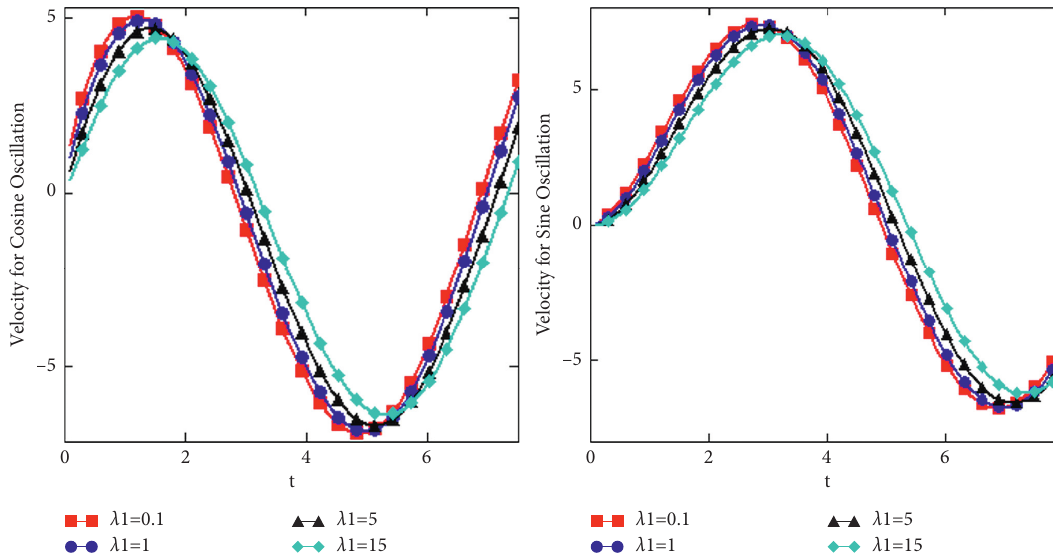
Figure 4: The variation of λ